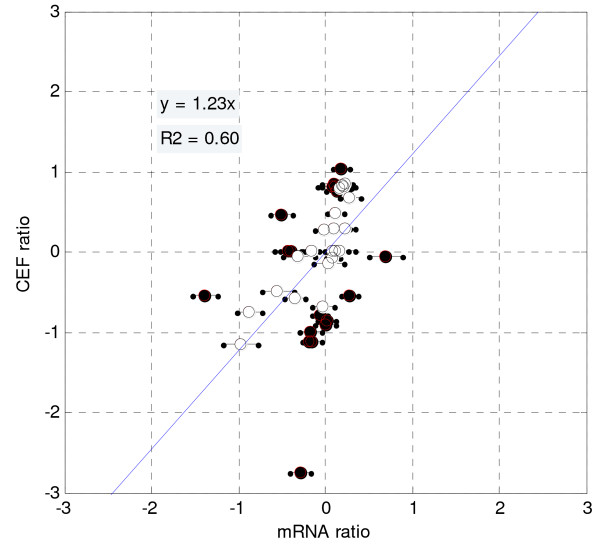
Comparison of the model-based and experimental data-based [36] logarithmic ratios for oxygen source perturbation from aerobic to anaerobic conditions in chemostat cultures. The filled circles are the omitted points to reach the selected threshold value of R2 = 0.60. The horizontal lines on the circles show 95% confidence intervals, calculated from standard deviation of the replicate measurements.